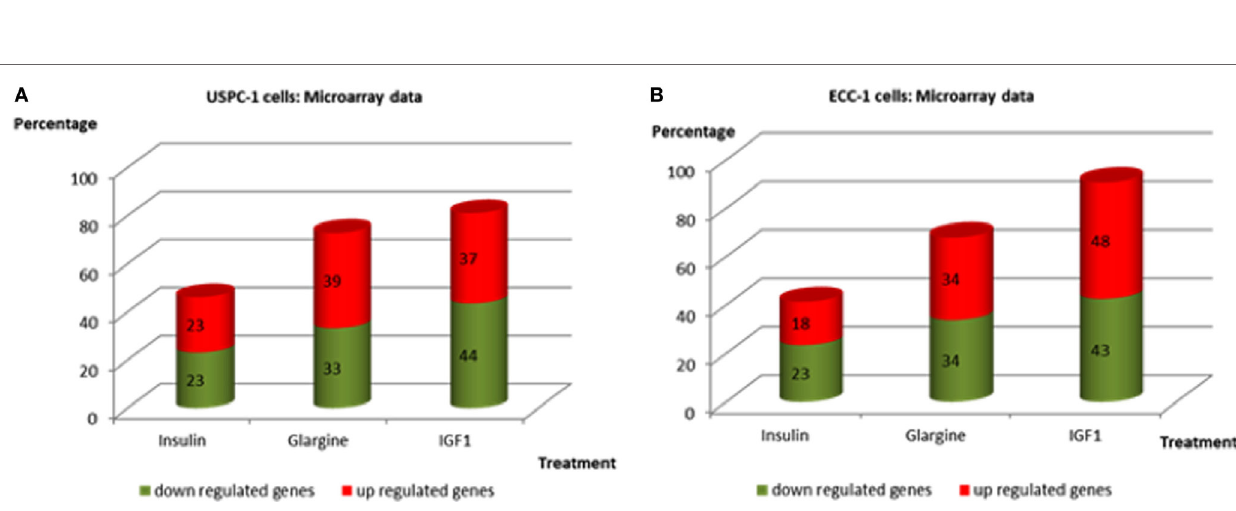
FigUre 7 | Commonly up- and downregulated genes by regular insulin, glargine, and IGF1 treatments in USPC-1 cells (a) and in ECC-1 cells (b) . Comparison of common genes up- and downregulated by insulin, glargine, and IGF1 (in percentages) in both cell lines.